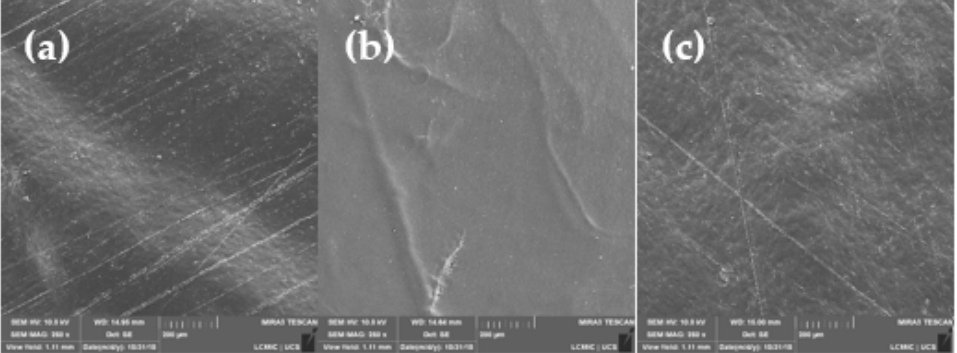
Figure 2. SEM images of the surface (250×) and cross-section (5000×) hemicellulose films: ( a , d ) 2 %(w/v), ( b , e ) 3 % (w/v), ( c , f ) 4 % (w/v). Figure 2. Cont